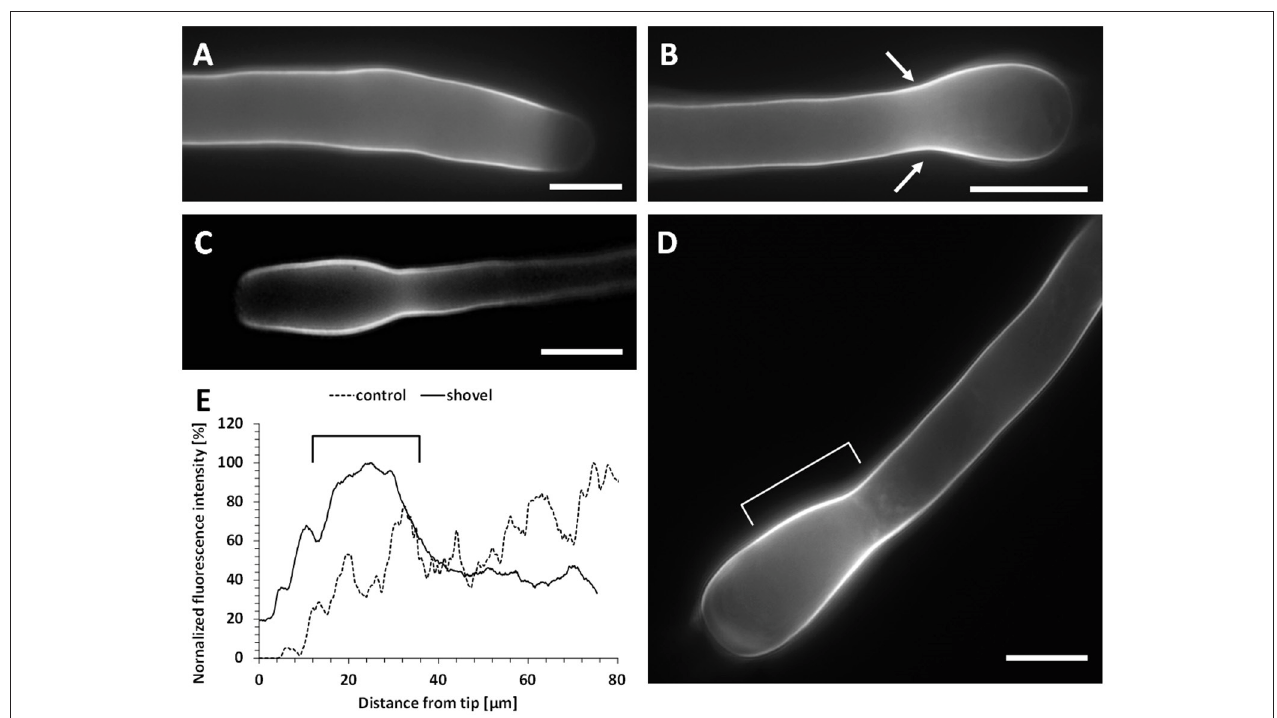
FIGURE 11 | Distribution of callose in Spm-treated pear pollen tubes. (A) A control pollen tube showing absence of callose in the tip. (B) In balloon-shaped pollen tubes, callose accumulates in the neck region (arrows). (C) In snake-shaped pollen tubes, callose still accumulates in the neck region and it is still absent from the tip. (D) In shovel-shaped pollen tubes, callose showed a consistent accumulation around 20–30 µ m, as also shown by the relative fluorescence intensity (E) . The square bracket in (D) corresponds to the region indicated by the square bracket in the graph of (E) . Bars: 10 µ m. Data are representative of three independent